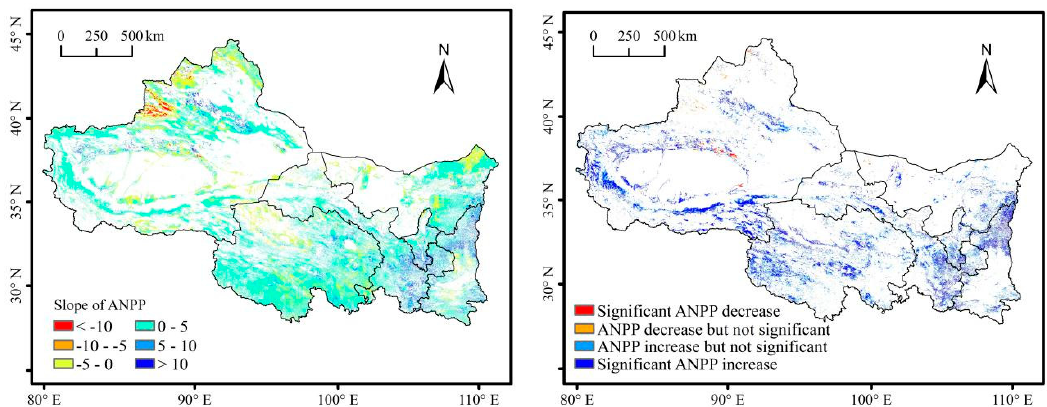
Figure 6. ANPP interannual rate of change and significance from 2001 to 2017.